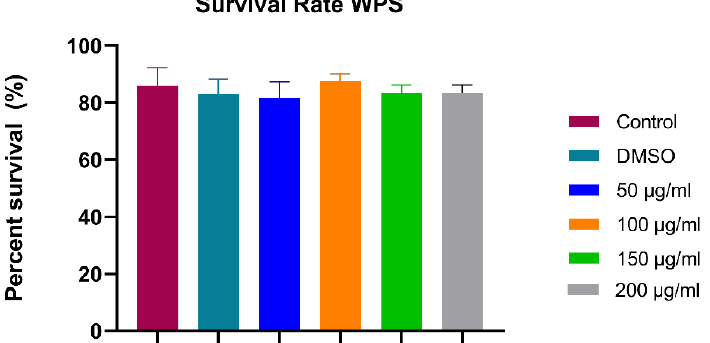
Figure 2. The survival rate of control embryos and experimental group at 24 h post-fertilization. All data are presented as mean ± SEM (20 embryos were used in each group; the experiment was per- formed in triplicate). One-way ANOVA with Sidak post hoc test was used to compare the differ- ences between groups.